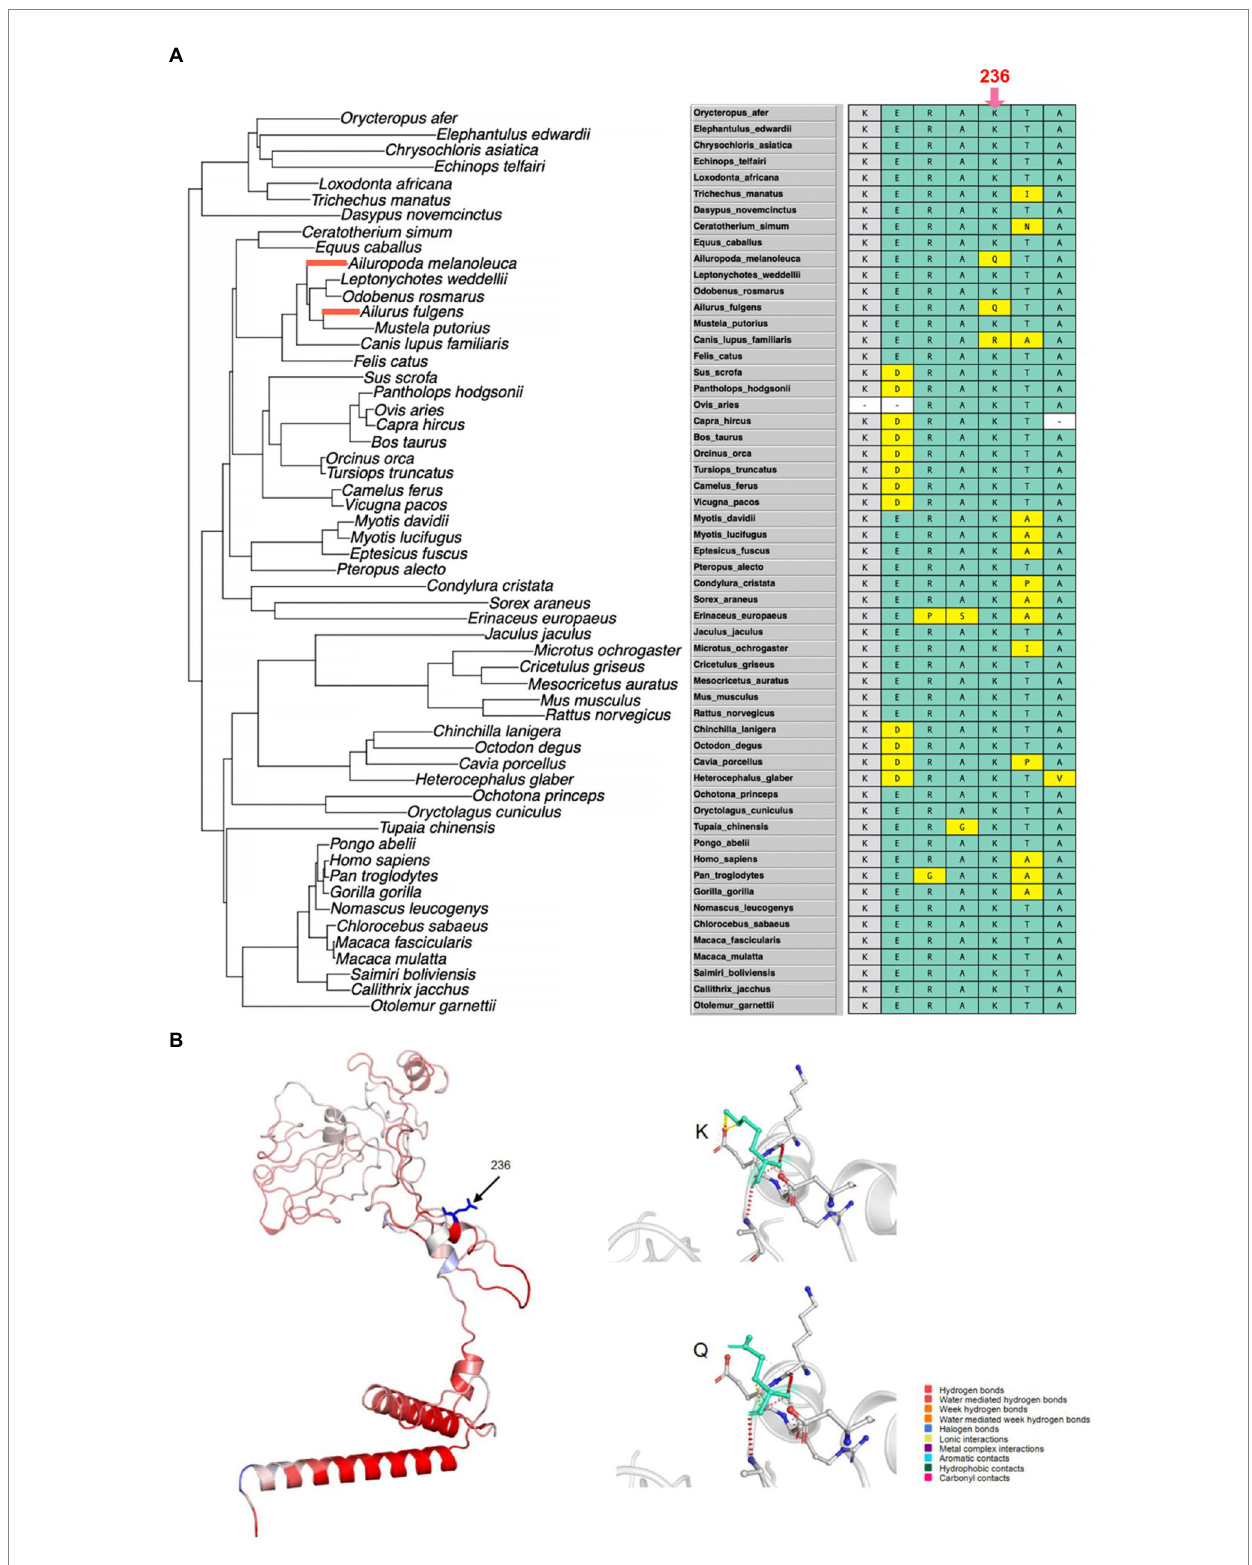
FIGURE 4 The convergent evolution of HOXC10 in the giant panda and red panda. (A) Left: The phylogenetic tree with the giant and red pandas highlighted by red branches. Right: Multiple sequence alignment of HOXC10 and the convergent amino acid change (Lys236Gln) between the two pandas indicated by the red arrow. (B) Left: The 3D structure of HOXC10 built by using a deep-learning-based method, trRosetta. The amino acids are colored according to the vibrational entropy change upon mutation. Blue represents rigidification of the structure, and red represents a gain in flexibility. Right: The results of interatomic interaction prediction. Wild-type and mutant residues are colored light green and are also represented as sticks alongside the surrounding residues that are involved in any type of